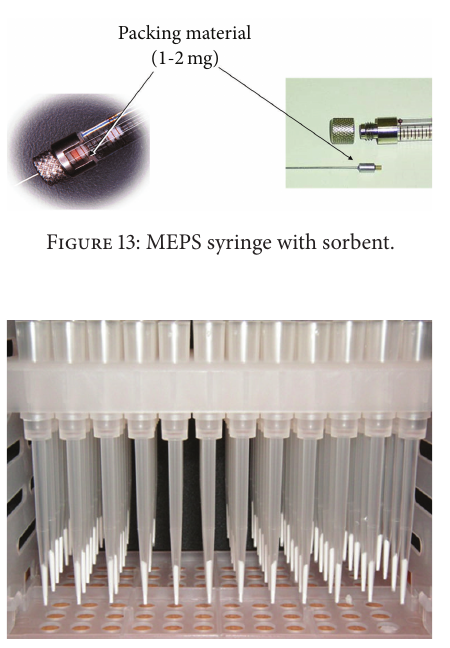
Figure 14: Monolithic packed